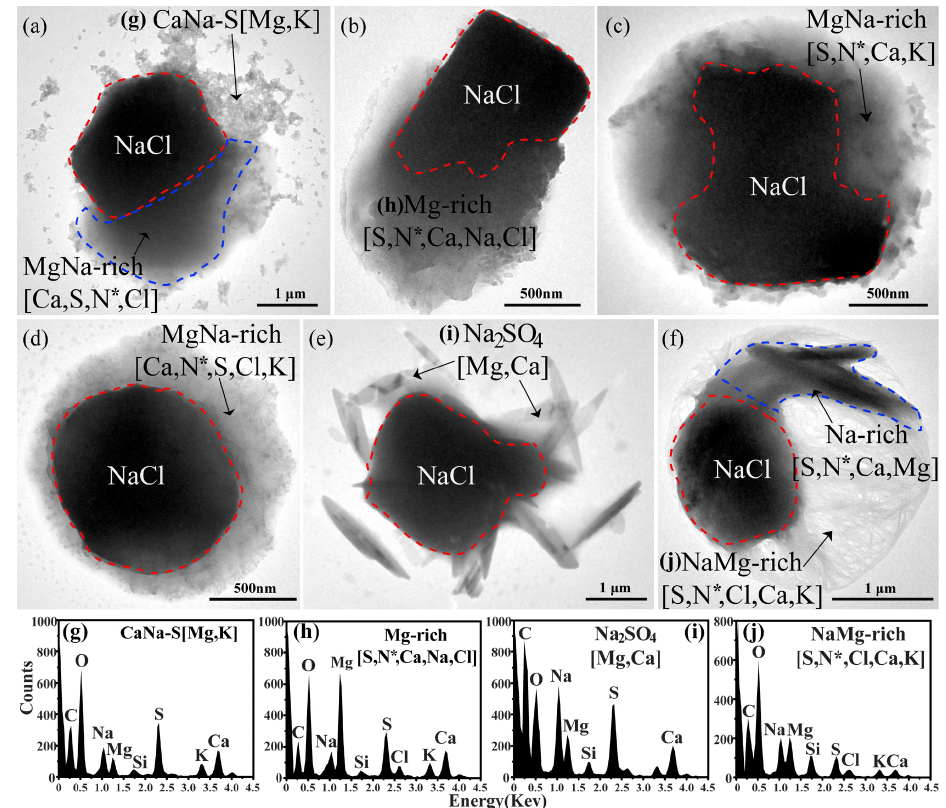
Figure 3. TEM images of typical partially aged SSA and EDX spectra of their coatings. ( a and b ) NaCl partially surrounded by the mixed species, containing Mg, Ca, Na, S, O, N and minor Cl; ( c and d ) NaCl completely surrounded by the mixed species with Mg, Ca, Na, S, O, N and minor Cl; ( e and f ) the rod-like Na 2 SO 4 particles (minor Mg, and Ca) associated with NaCl. (g–j) The EDX spectra of one selected area in the internally mixed coating, including Na, Ca, Mg, S, and O with minor Cl and K. N cannot be directly measured but is inferred based on elemental composition in